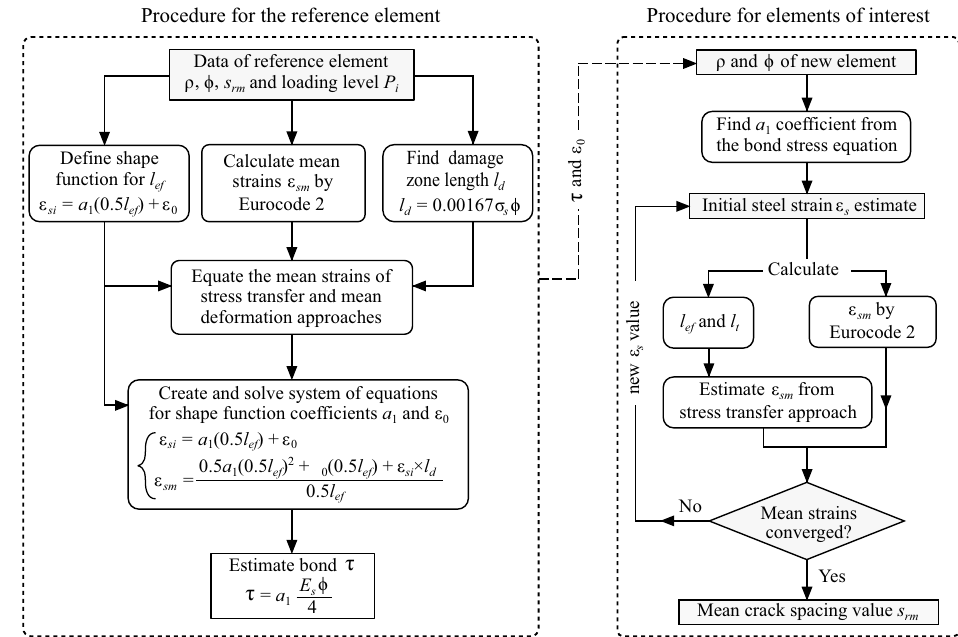
Figure 4. Flowchart of the proposed crack spacing prediction technique with debonding included